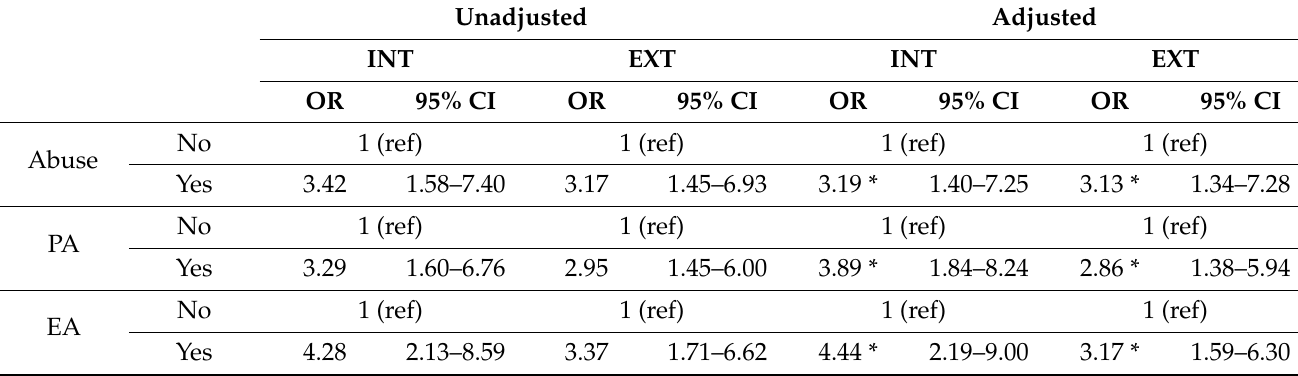
Table 3. Logistic regression analysis between recent abuse and psychopathology at baseline. Unadjusted